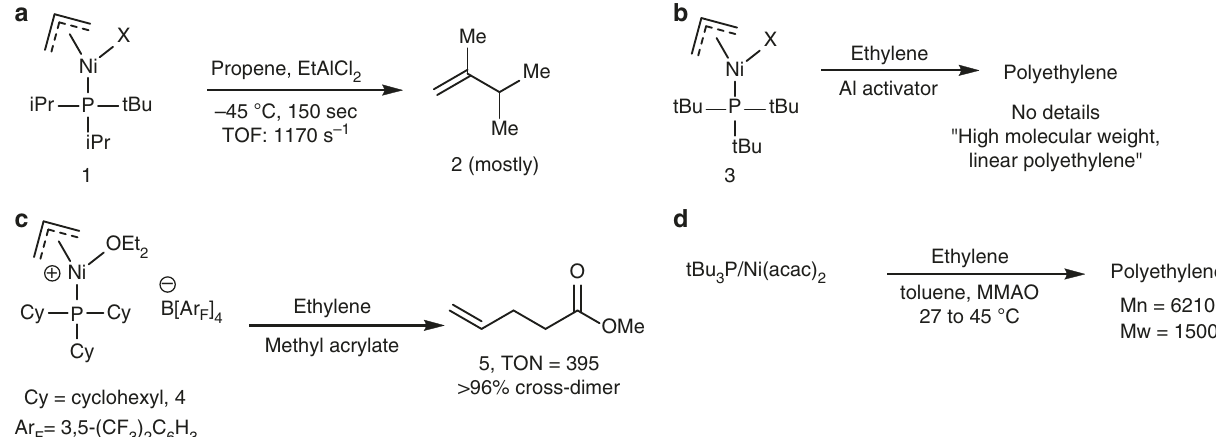
Fig. 1 Monodentate trialkylphoshine-nickel catalysts for ole fi n dimerization and polymerization . a Propylene dimerization with exceptionally high initial turnover frequencies (Wilke). b Ethylene polymerization using tri- t -butylphoshine-nickel complex (Wilke). c Ole fi n cross-dimerization using tri- cyclohexylphosphine nickel catalyst. d Ethylene polymerization using tri- t -butylphoshine-nickel-acac catalyst generated in